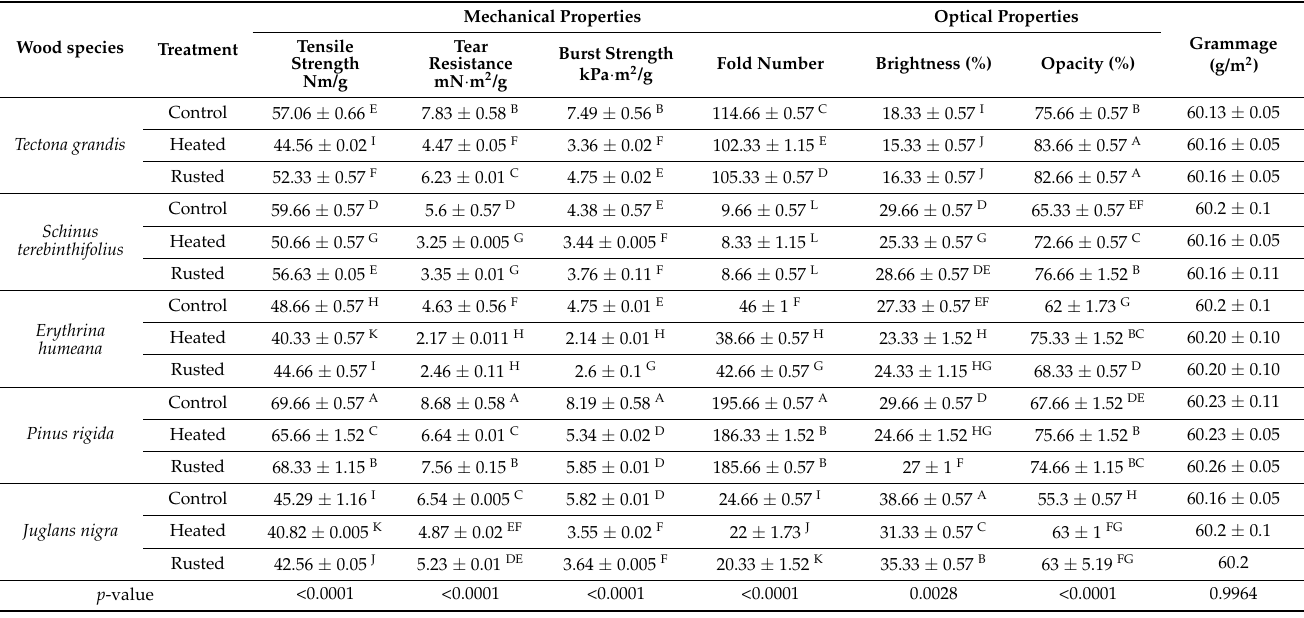
Table 6. Mechanical and optical properties of handsheets produced from heated or rusted wood pulp compared to untreated